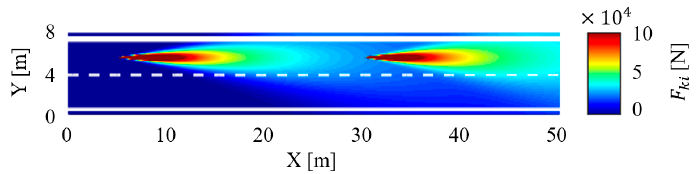
Figure 10. The time-varying traffic risk map in the car-following scenario.